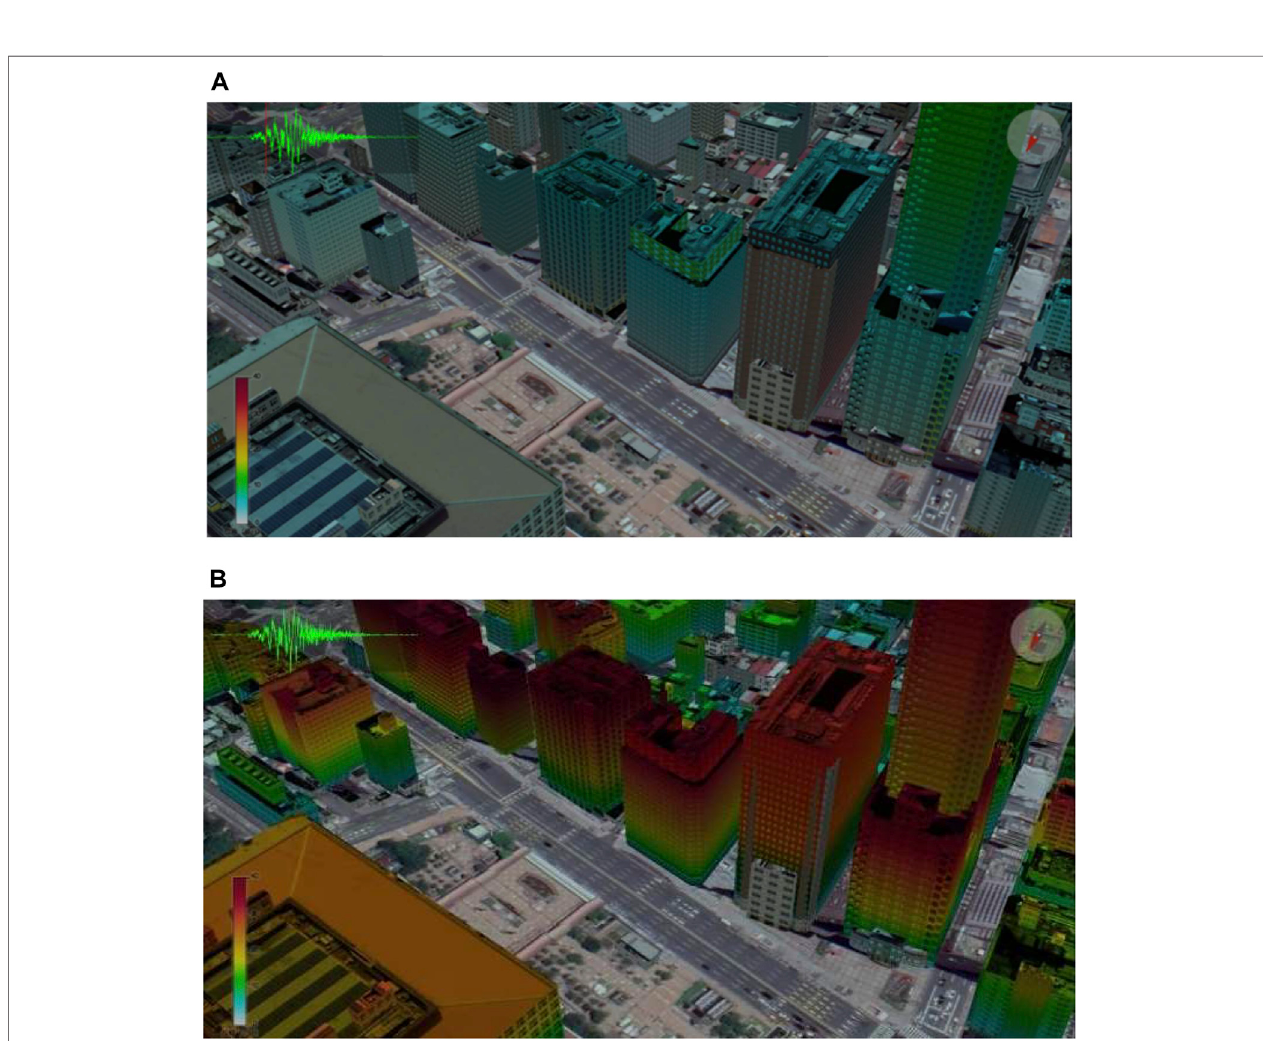
FIGURE 21 | Temporal simulation results of the building models: (A) t = 10 s and (B) t = 20 s.